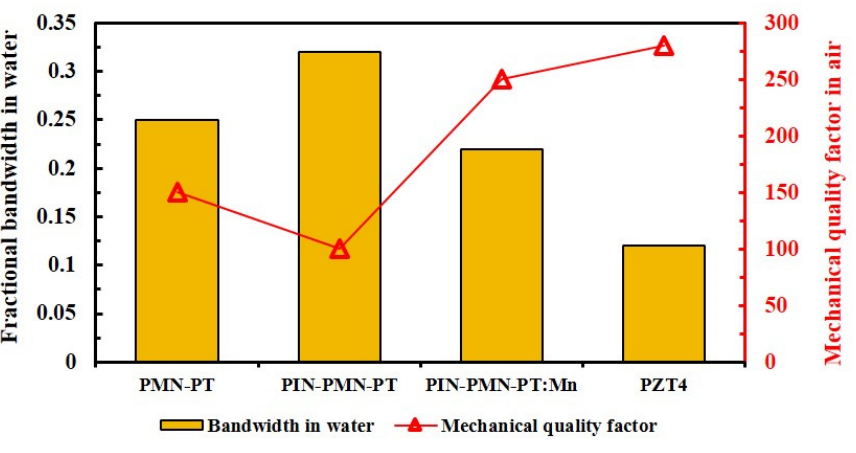
Figure 8. Bandwidths and quality factors of Tonpilz-design transducers made of PMN-PT, PIN- PMN-PT, Mn-modified PIN-PMN-PT crystals and PZT4 ceramic [184]. PT, Mn-modified PIN-PMN-PT crystals and PZT4 ceramic